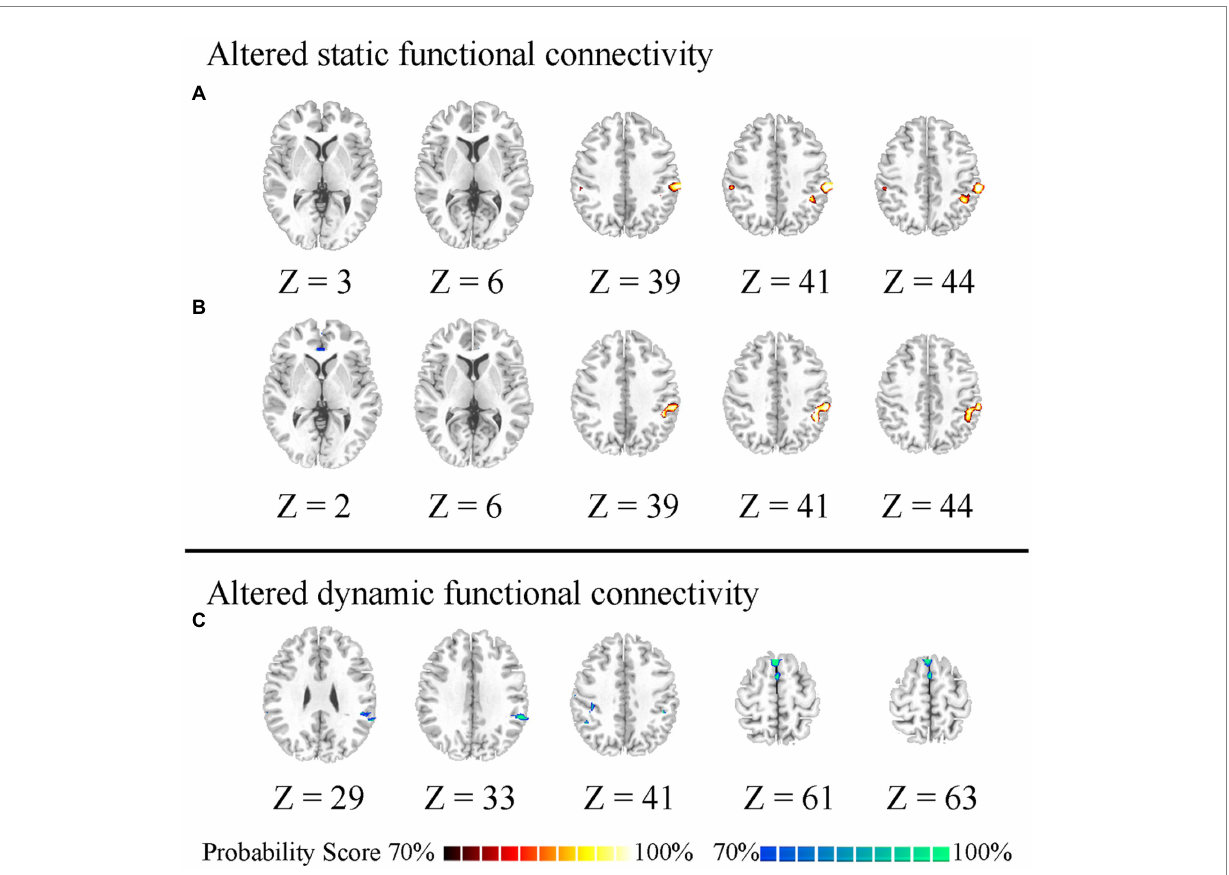
FIGURE 2 Probability difference map. “70%” indicates the percentage of significant difference of 200 statistical analyses between the part of the high worry- proneness group (HWP) and low worry-proneness group (LWP). (A) indicates increased static FC between the right ventral insula and right temporoparietal junction (TPJ) in HWP. (B) indicates increased static FC between the left ventral insula and right TPJ and decreased static FC between the left ventral insula and pregenual anterior cingulate cortex in HWP. (C) indicates decreased dynamic FC between the right posterior insula and right TPJ, as well as supplementary motor area in